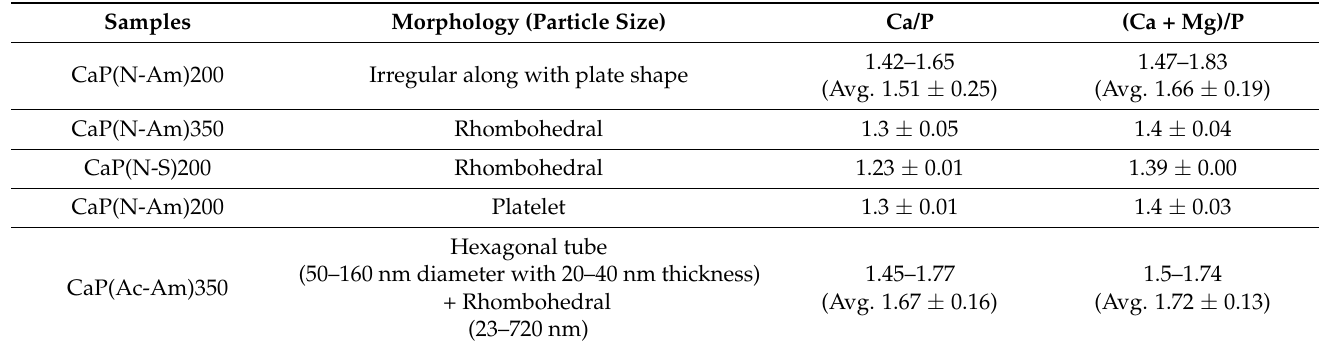
Table 5. The morphology including the particle sizes and the ratios of Ca/P and (Ca + Mg)/P of